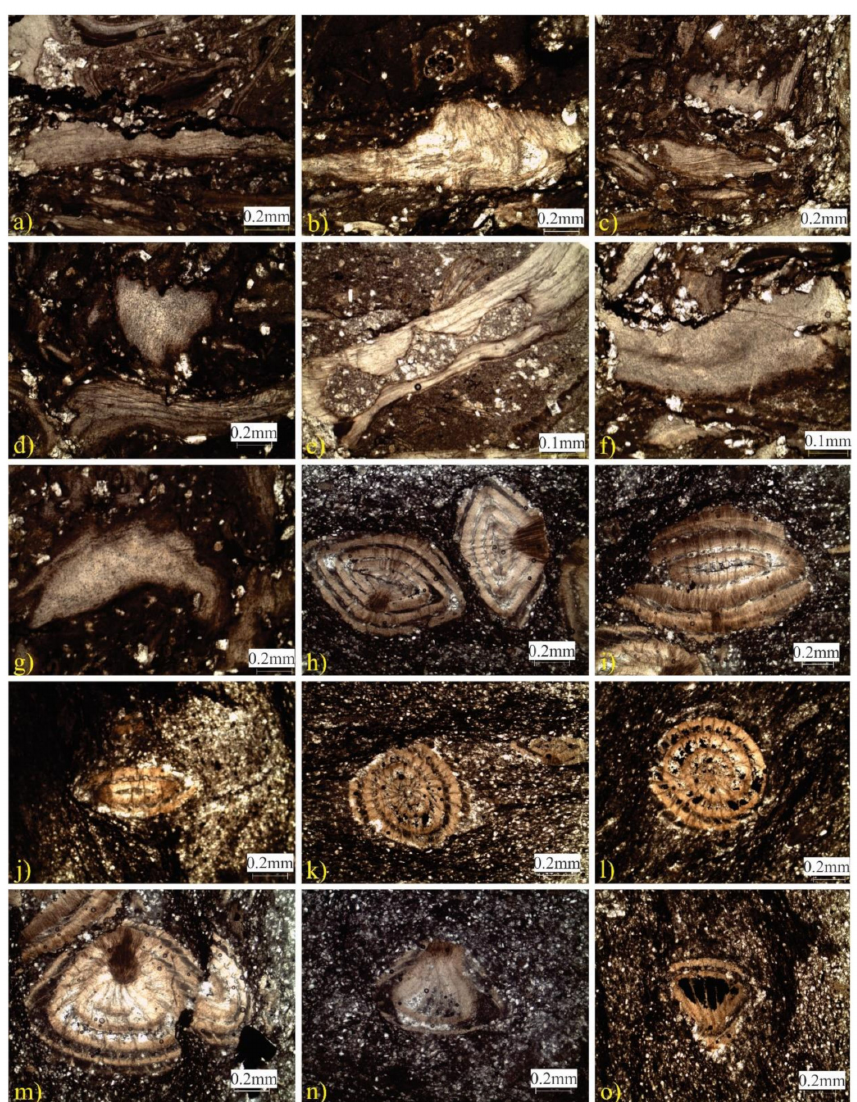
Figure 12. Photomicrographs of the bioclasts found in the limestone of the study area. ( a – g ) Gloibigeri- noides species, nummulites spp. ( h – j , m ), ostracods and bivalved brachiopods ( k , l ), Lockhartias spp. ( n , o